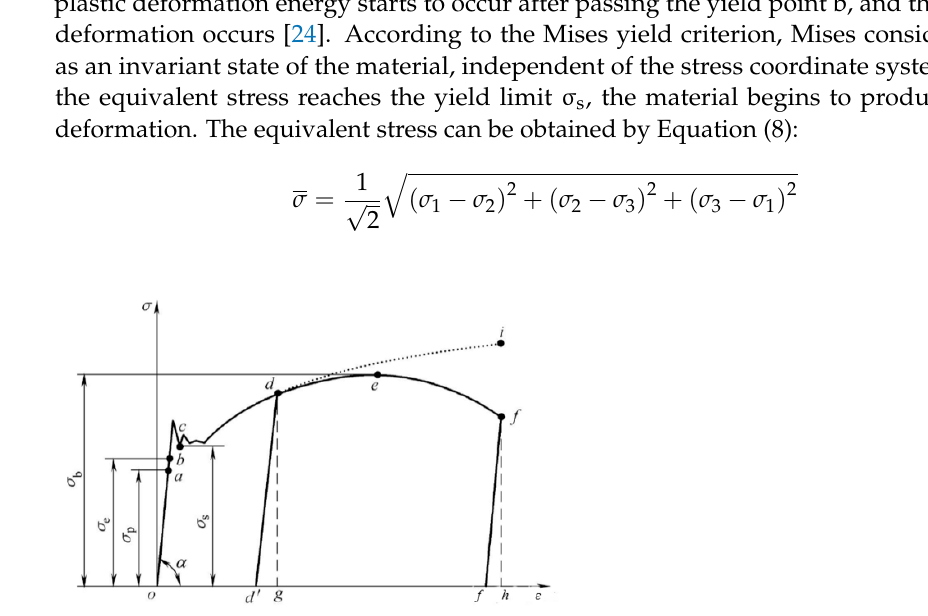
Figure 8. Stress–strain curve.